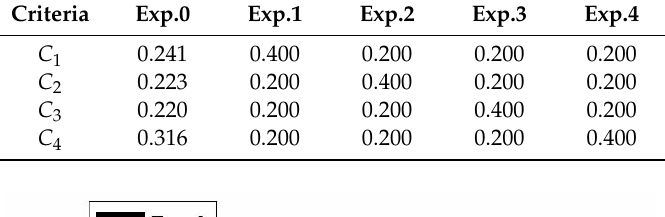
Table 9. Weights of criteria in the sensitivity analysis.